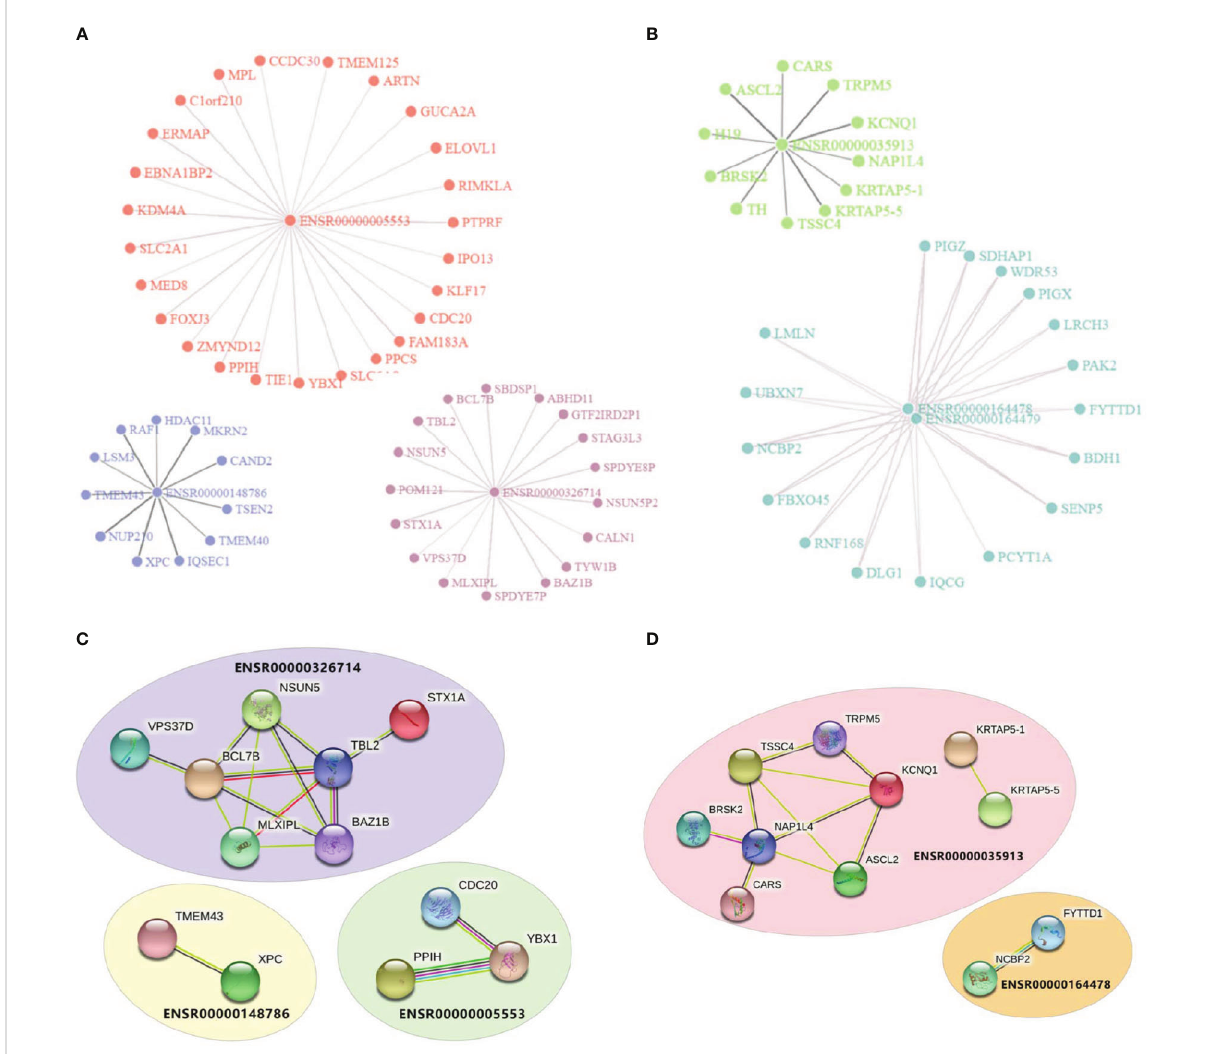
FIGURE 2 Visualization of enhancer-target interaction network and functional enrichment. (A) Target genes of irAE-related enhancers